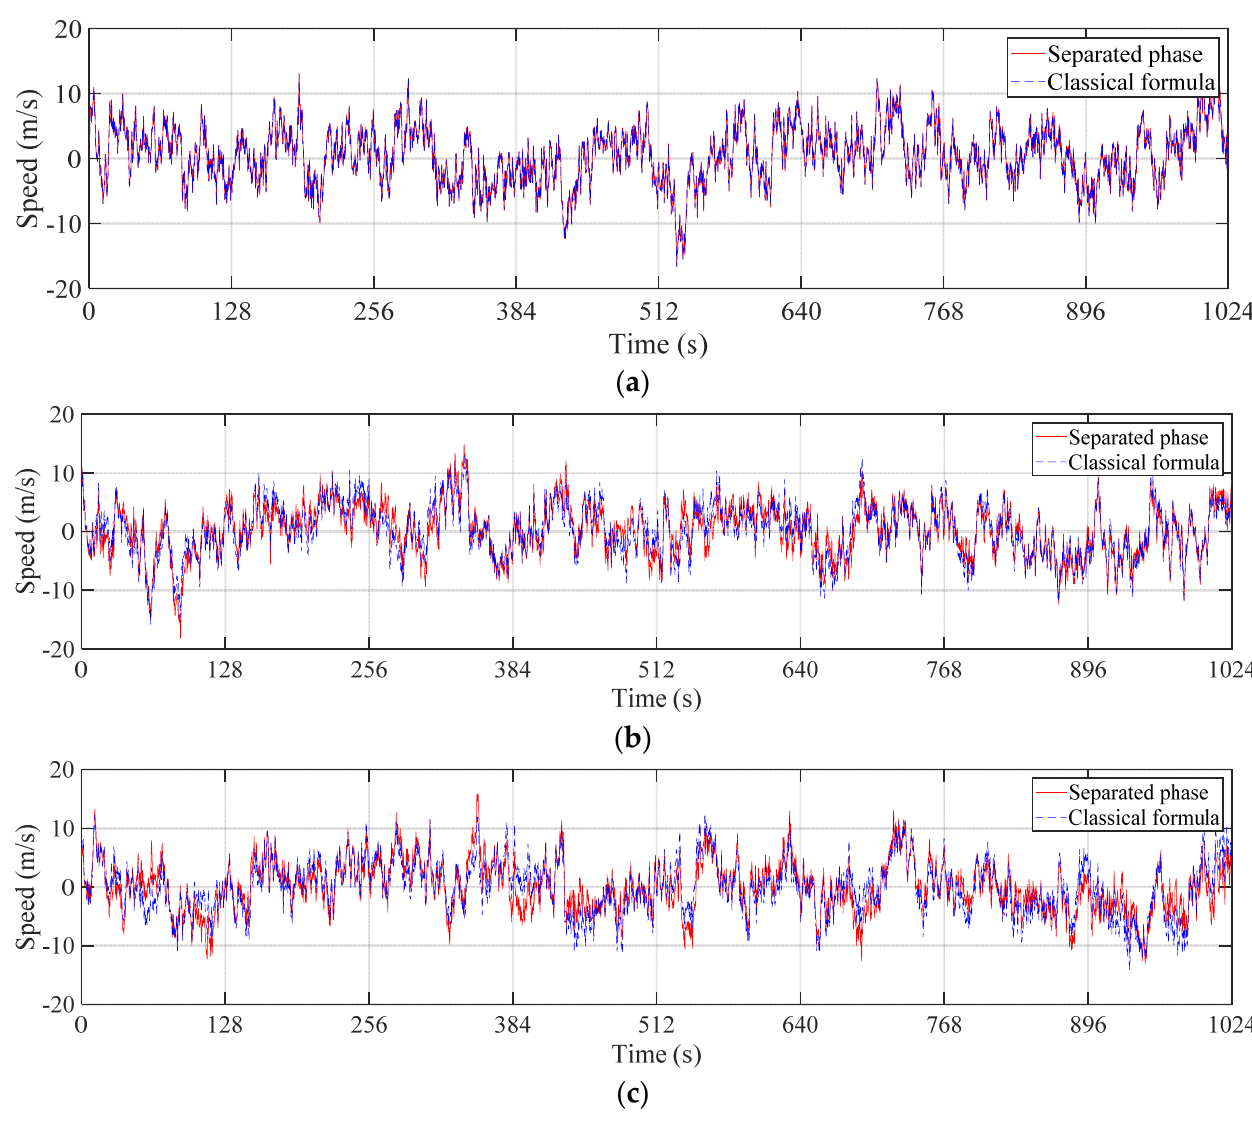
Figure 3. Simulated nonergodic stationary wind fluctuation samples: ( a ) Point 1; ( b ) Point 21; ( c ) Point 41.